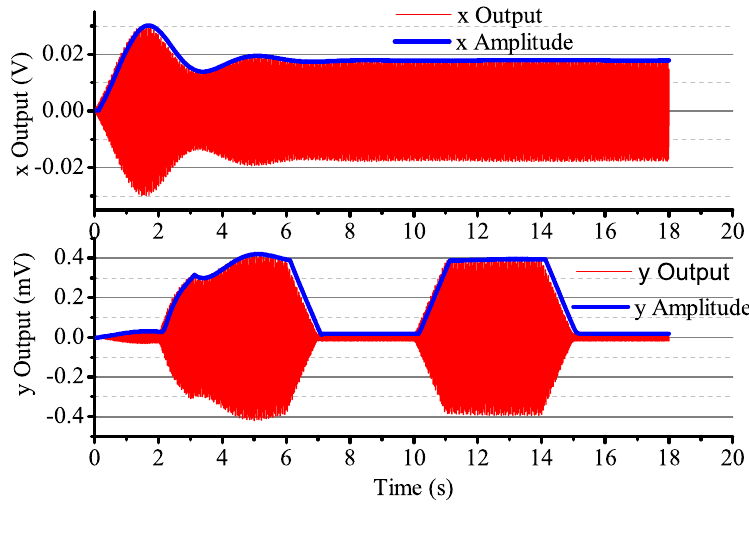
Figure 20. The calculated angular rate output with control in Ω is